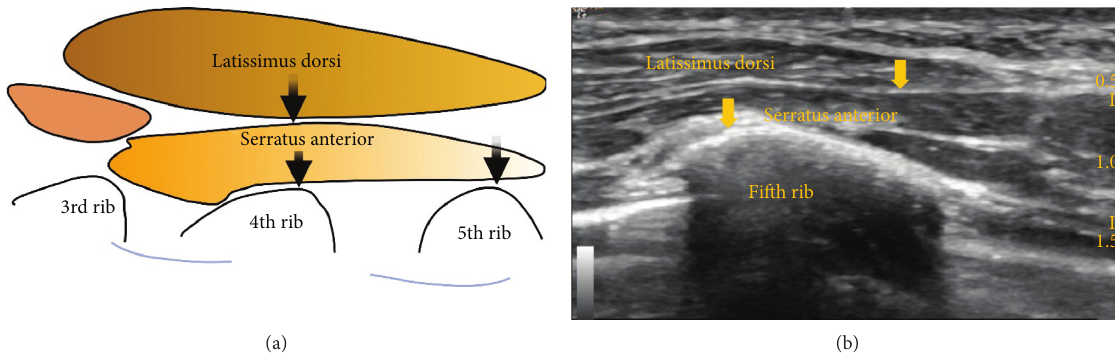
Figure 2: Black and yellow arrows indicate the point of local anesthetic infiltration.